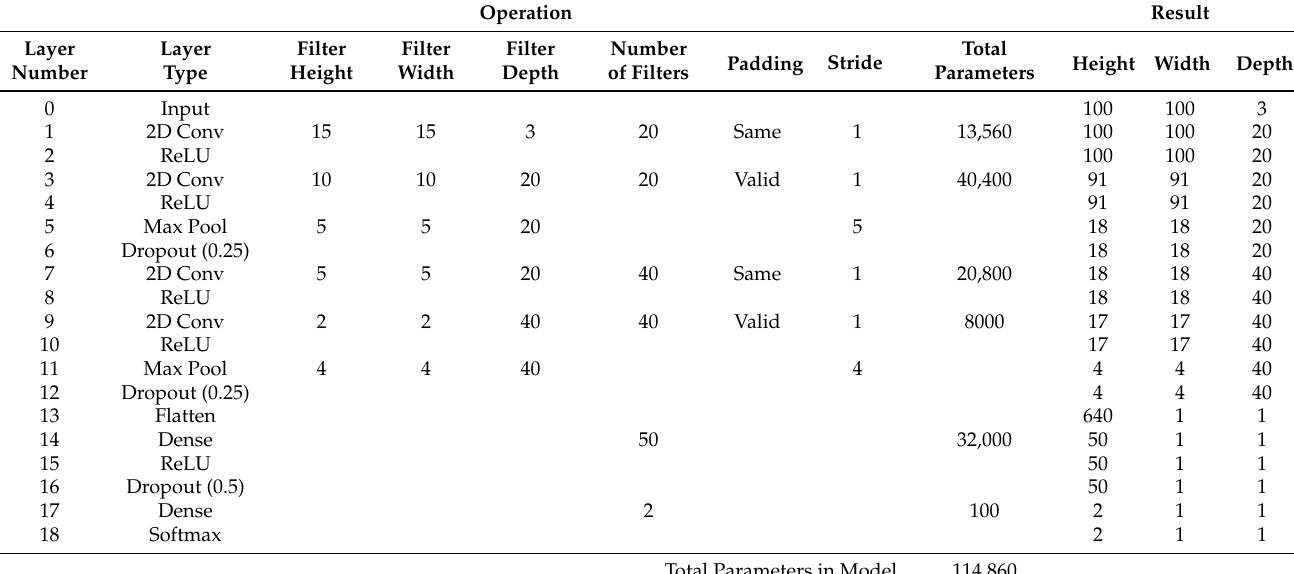
Table 2. Details of CNN Architecture B, a hybrid